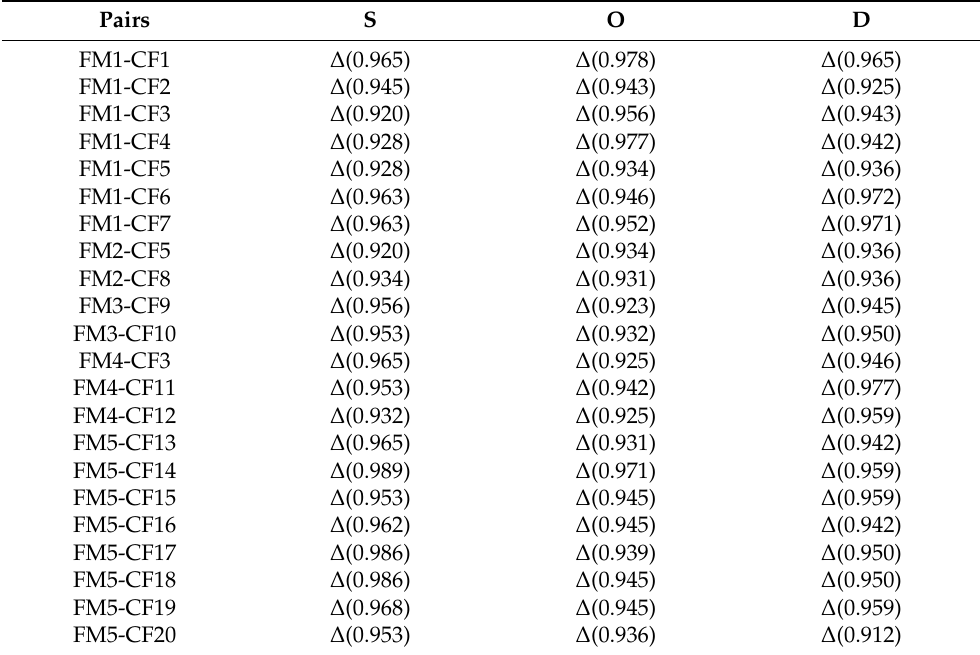
Table 9. The grey relational coefficient for pairs of FMs and